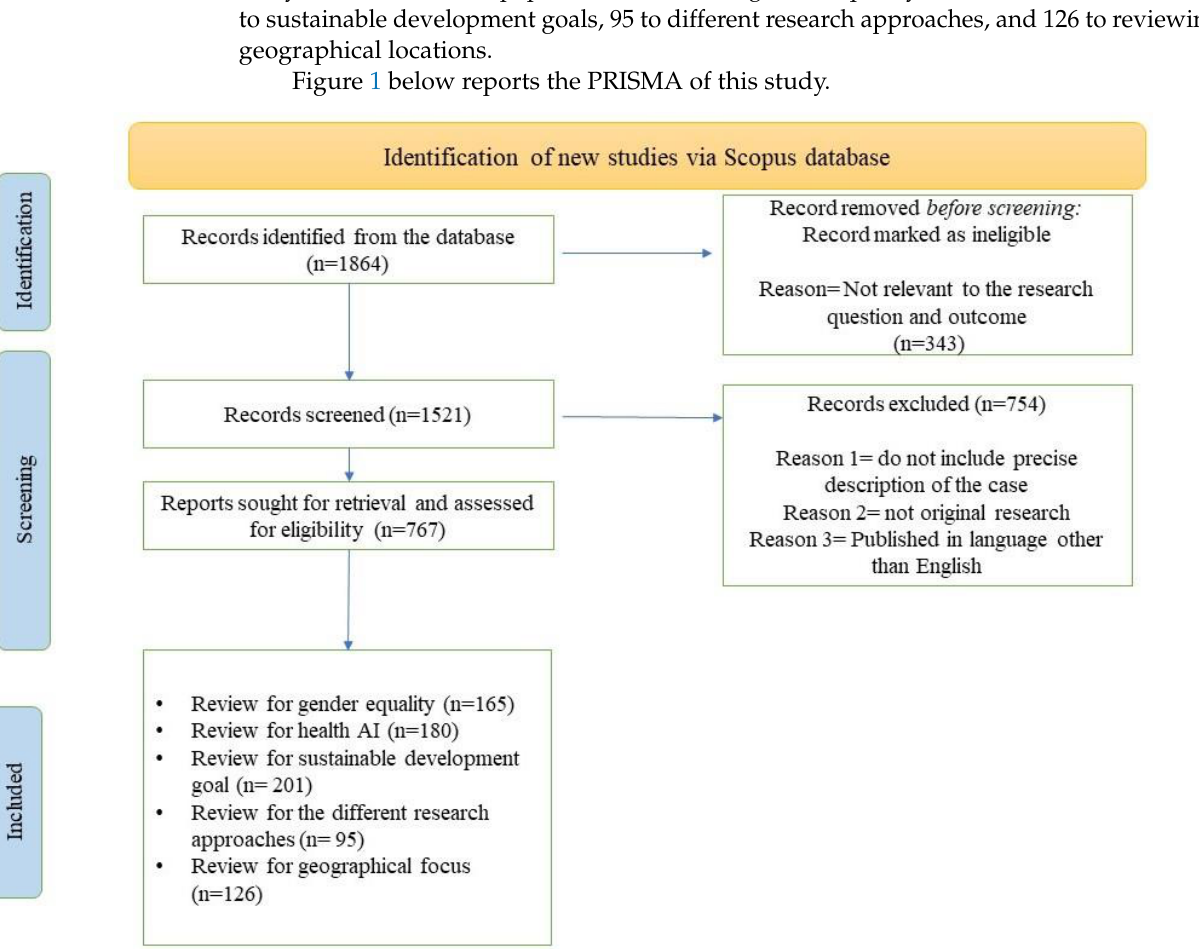
Figure 1. PRISMA Flow Diagram.